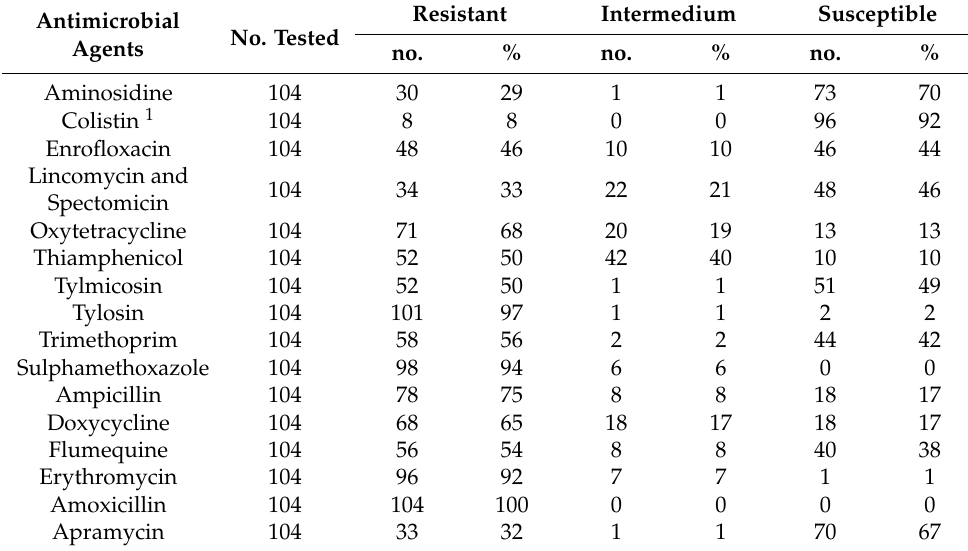
Table 1. Antibiotic-resistance pattern of E. coli population.